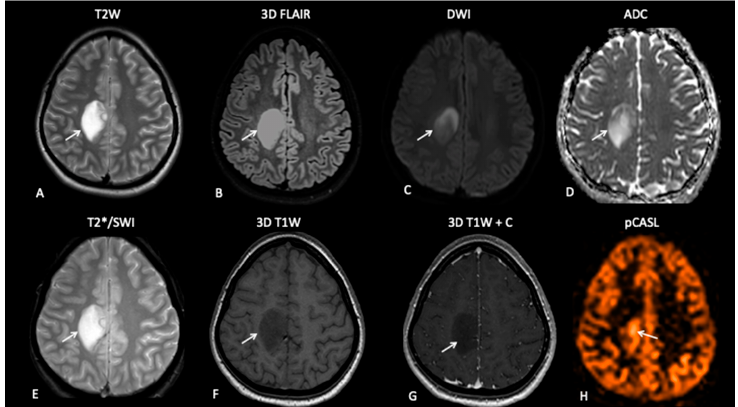
Figure 1. Nineteen-year-old female presenting with epilepsy. MRI demonstrates a well-defined T2W ( A ), FLAIR ( B ), DWI ( C ) and a hyperintense lesion with a medial border of restricted diffusion on an apparent diffusion coefficient (ADC) map ( D ). The lesion demonstrates no areas of susceptibility ( E ) and no pathological enhancement on pre- and post-contrast T1W images ( F , G ). The appearances are consistent with low-grade glioma, but pCASL perfusion-weighted imaging (PWI) ( H ) demonstrates medial increased perfusion. A variation of this method acquires two high-resolution 3D T1-weighted sequences in the same MRI session, and 3–5 and 60–75 min after the injection of the contrast medium and subsequent subtraction a colour-coded map known as a treatment response assessment map (TRAM) is produced. Areas where contrast accumulates correspond histologically to treatment-induced changes, whilst areas where contrast is cleared rapidly correspond to active tumour [50]. TRAMs are simple to acquire but can be inconvenient to the patient who may have to wait longer to complete the study, a particularly challenging in the paediatric population.